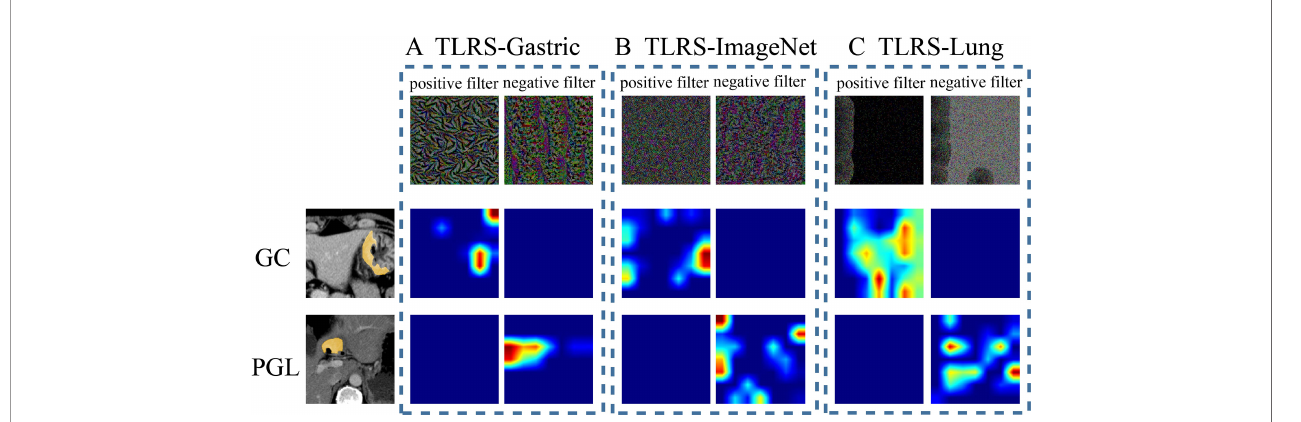
FIGURE 5 | Visualization of two patient samples for the three methods. (A) The TLRS-Gastric is based on the WSIs of GC. (B) The TLRS-ImageNet is based on the ImageNet dataset. (C) The TLRS-Lung is based on the WSIs of the lung. The positive and negative fi lters for the three methods are in the fi rst row. In the second and third rows, the response heat map of the two patients ’ negative and positive transfer learning features was noted. The red region represents a larger weight, which shows that the model focuses on the area of the CT image. GC, gastric cancer; PGL, primary gastric lymphoma; TLRS, transfer learning radiomics